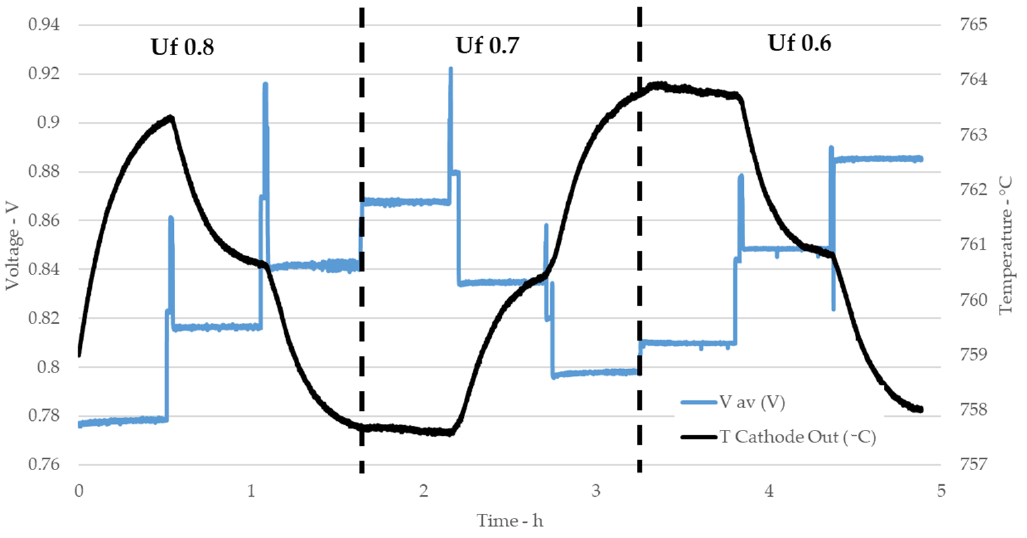
Figure 4. Example of stack test: average cell voltage and cathode temperature as function of time.